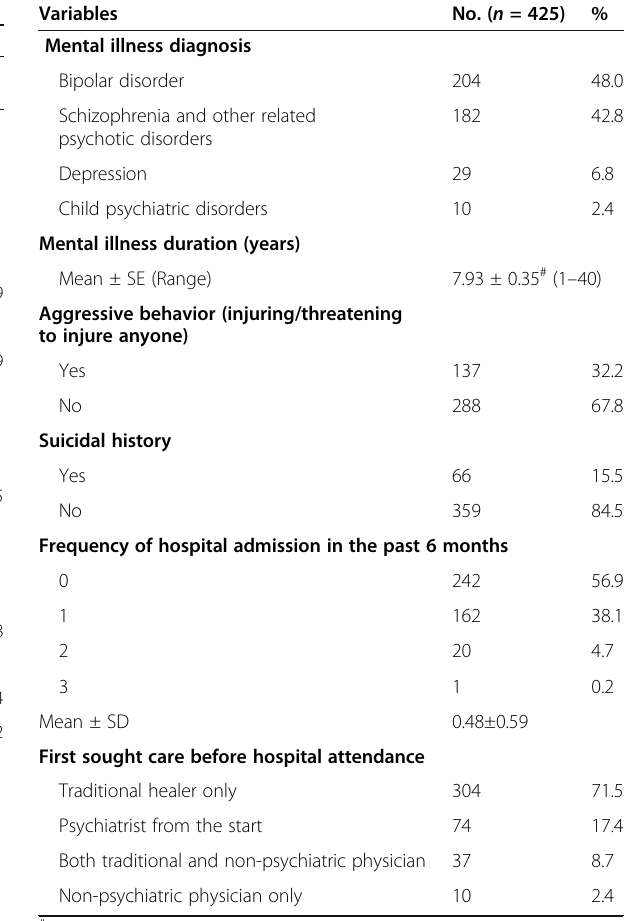
Table 1 Socio-demographic characteristics of the study caregivers and their mentally ill patients, Assiut University